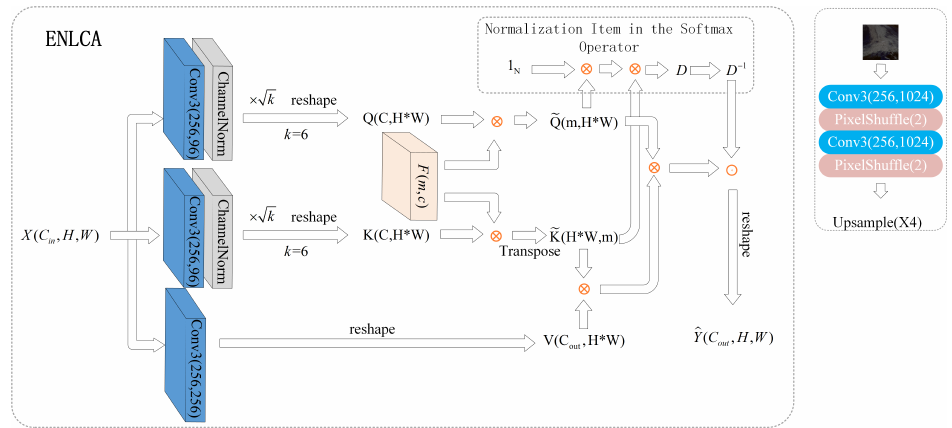
Figure 8. Blocks in ENLCA.